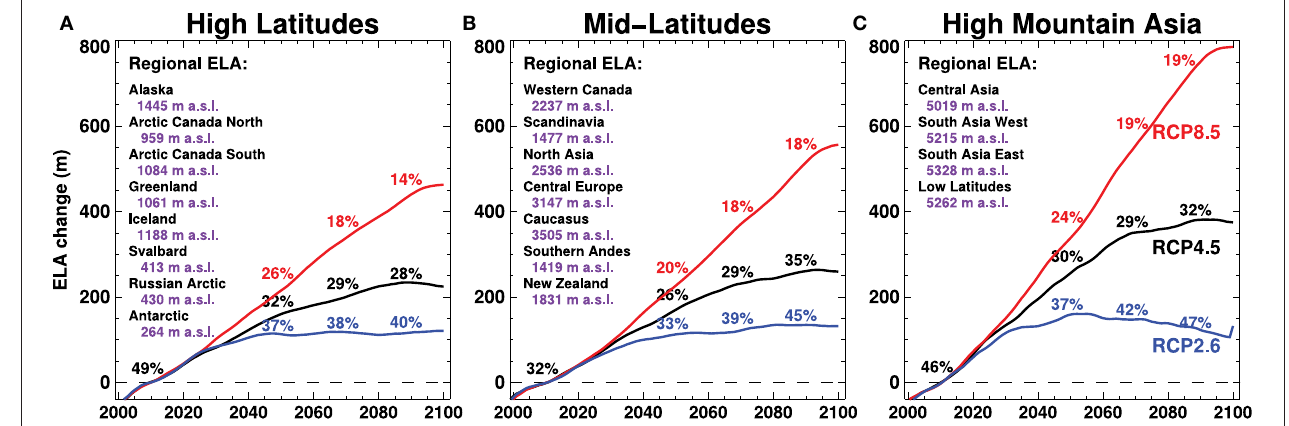
FIGURE 9 | Changes in regional equilibrium line altitudes (ELAs) relative to 2010 for (A) high, (B) mid-, and (C) low latitudes and three emission scenarios. Accumulation area ratios (in %) are given as 20-year averages around 2010, 2050, 2070, and 2090. All values after 2010 are multi-model means. ELAs and AARs are averaged (weighted by glacier area) over all glaciers in the RGI regions listed in each panel. Average ELAs are given for each region for the year 2010.